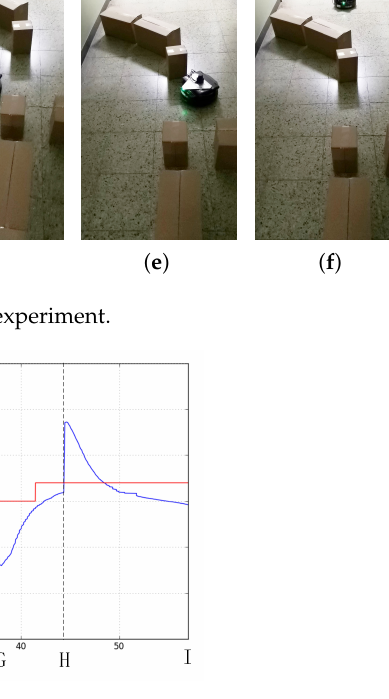
Figure 15. Linear velocity ( red ) and the angular velocity ( blue ) of the robot during the